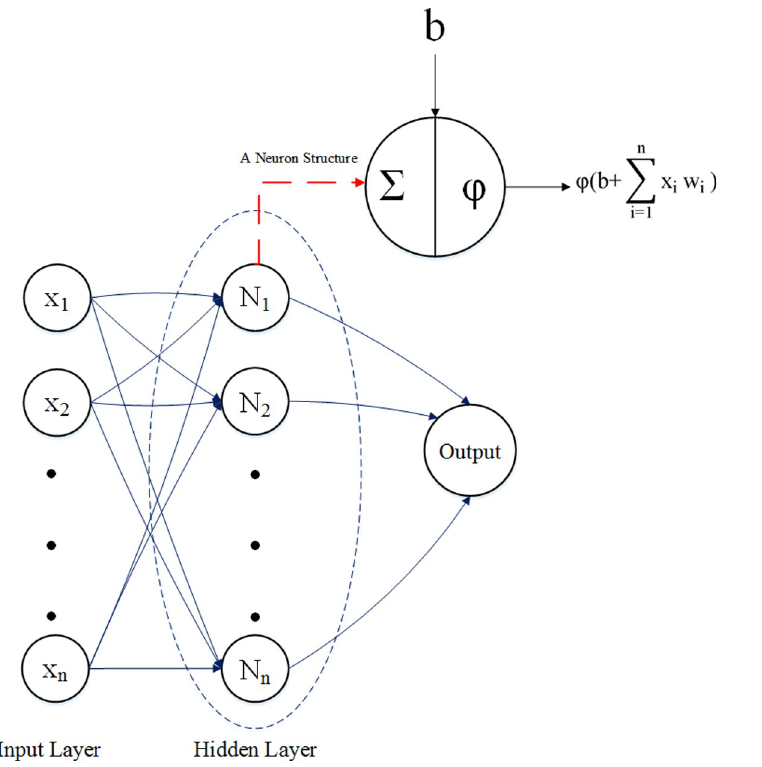
Fig 2. Structure of the multilayer perceptron with one hidden